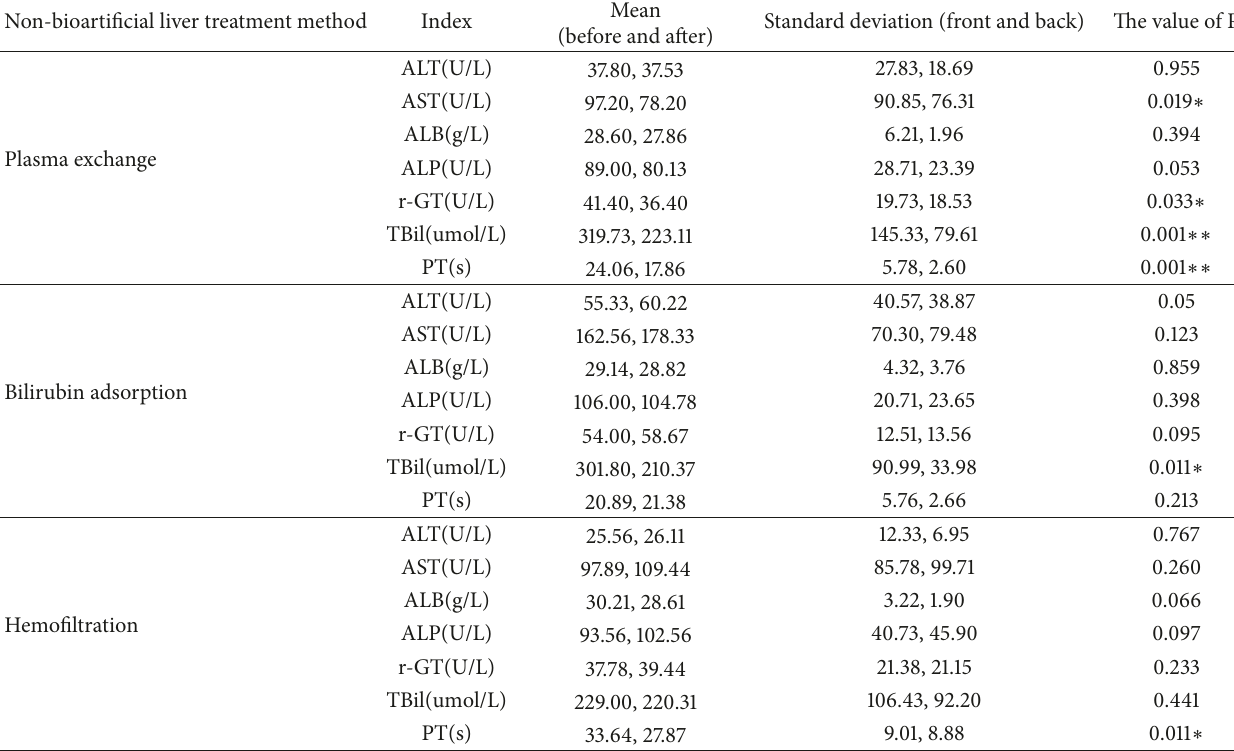
Table 8: Clinical analysis of different nonbioartificial liver treatment patterns in patients with chronic liver failure. Non-bioartificial liver treatment method